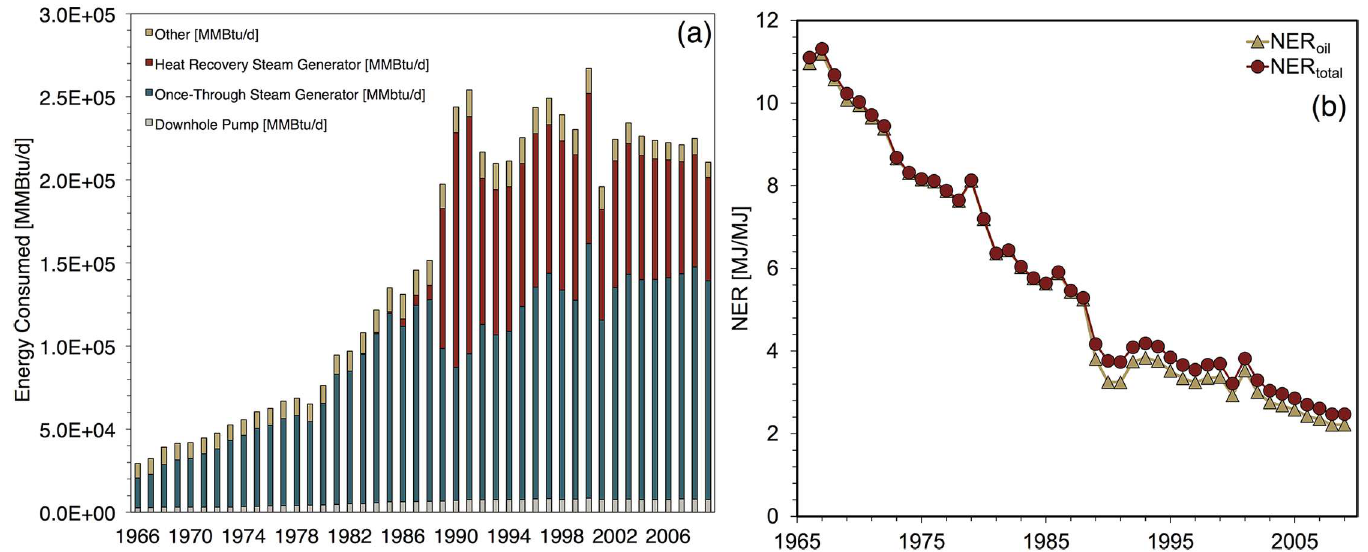
Fig 9. Midway-Sunset base case results showing (a) total energy inputs for major processes(b) NER